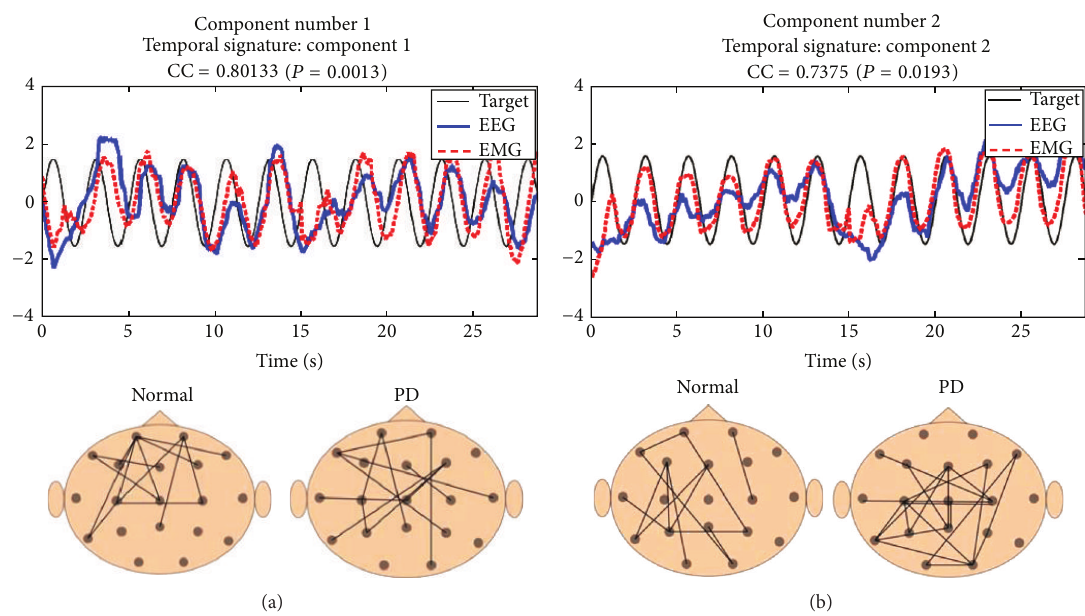
Figure 6: The two components from the proposed PLS + CCA method when using the EEG correlation features and the EMG amplitude features as data sets. Top panel: temporal patterns of the EEG (blue, solid) and the EMG (red, dashed). The oscillation of the target bar is also shown (black, solid). Bottom panel: EEG spatial patterns of normal subjects (left) and PD subjects (right). The connections reflect the respective spatial patterns in the two groups. CC means correlation